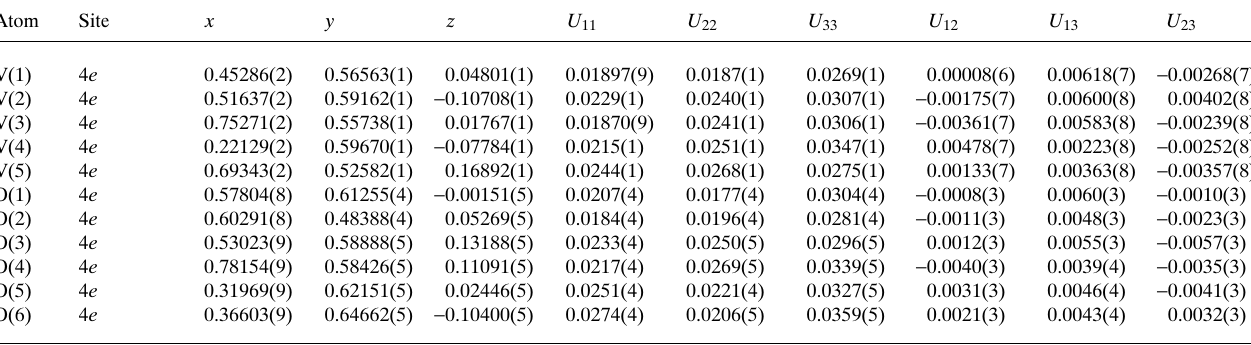
Table 3. Atomic coordinates and displacement parameters (in Å 2 ) .